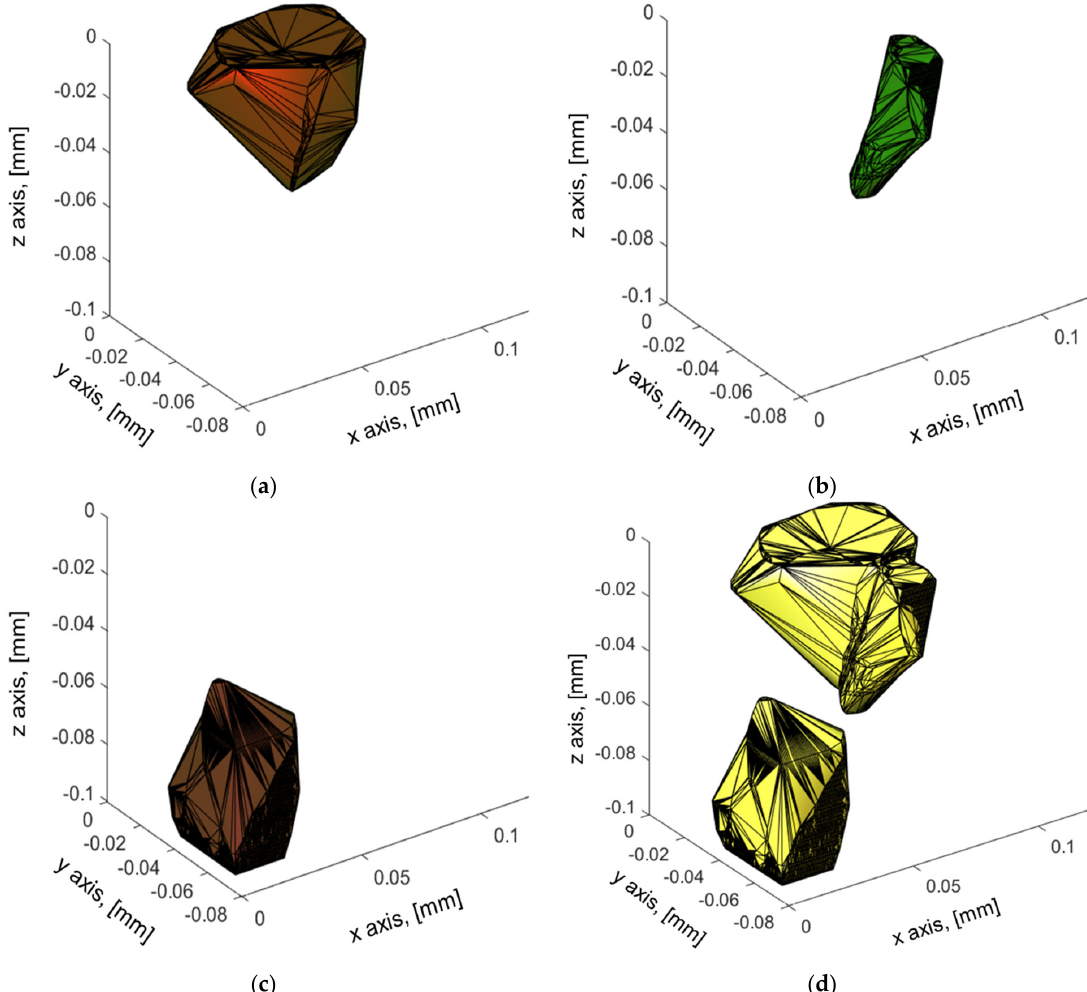
Figure 10. Three-dimensional volumetric imaging of grains with except discontinuous layers. ( a ) 3D image of #1; ( b ) 3D image of #3; ( c ) 3D image of #6; and ( d ) 3D image of three grains.